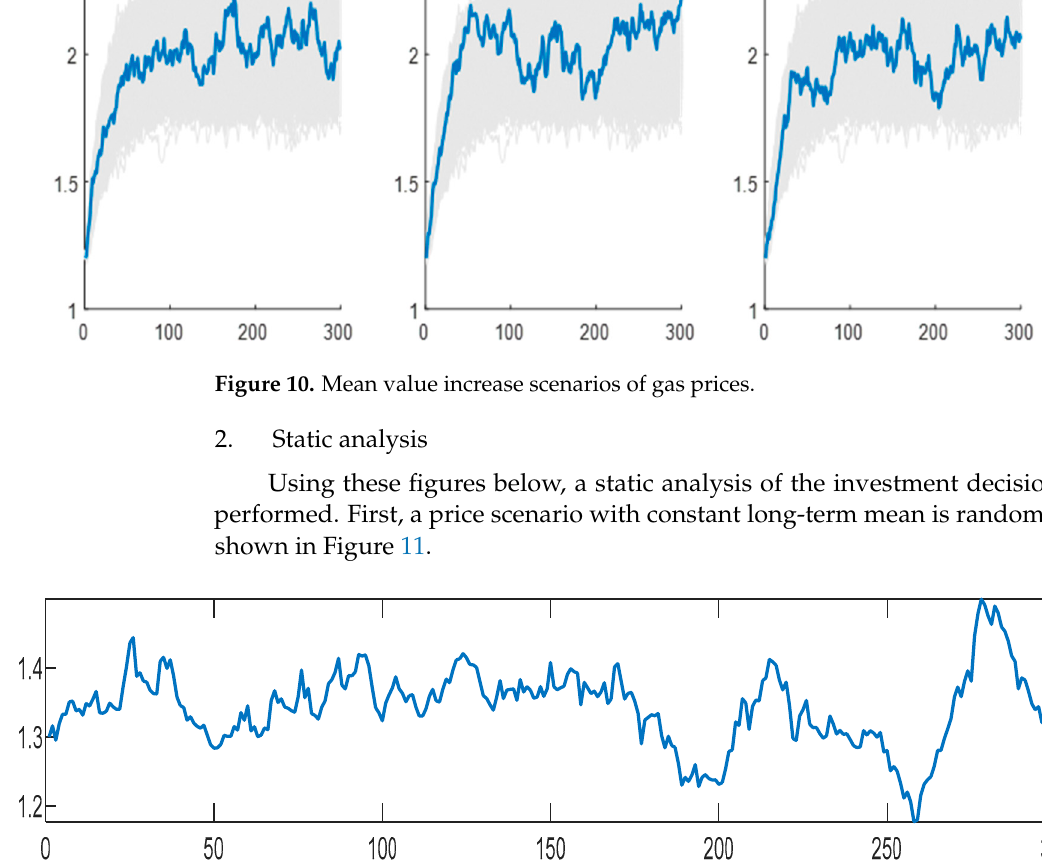
Figure 10. Mean value increase scenarios of gas prices.